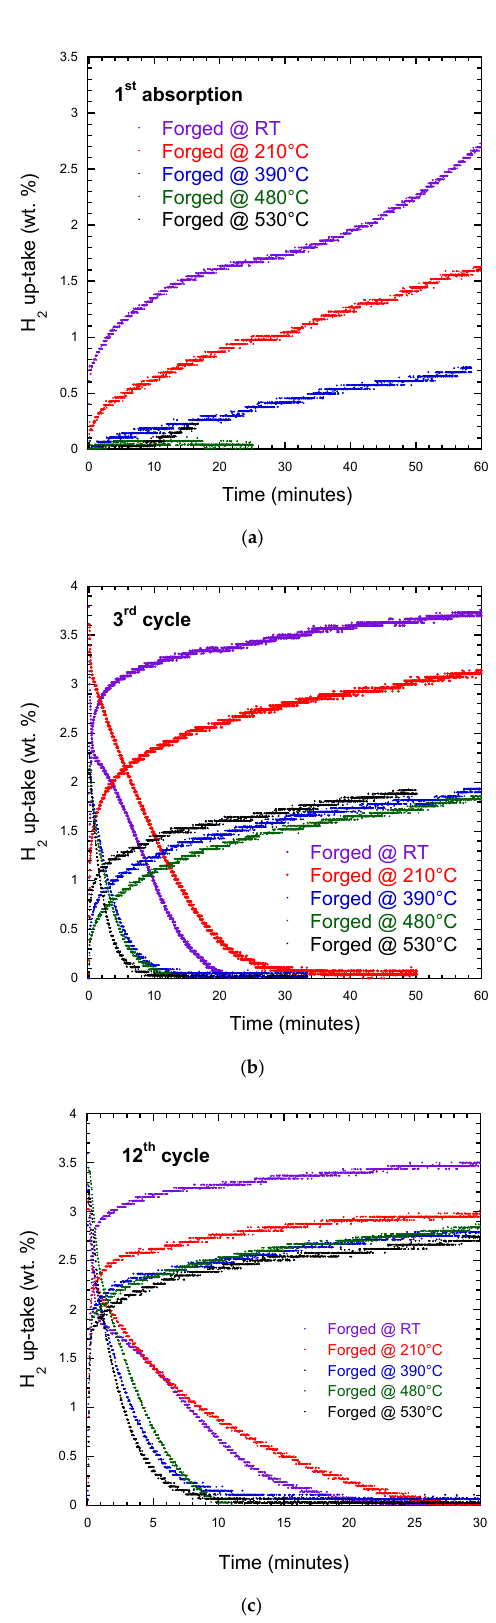
Figure 9. Absorption and desorption kinetics recorded on samples forged at RT, 210 °C, 390 °C, 480 °C, and 530 °C. ( a ) 1st absorption, ( b ) 3rd cycle, and ( c ) 12th cycle. Hydrogen pressure cycles were applied at 325 °C, with respectively 2 MPa and 150 kPa for absorption and desorption steps.